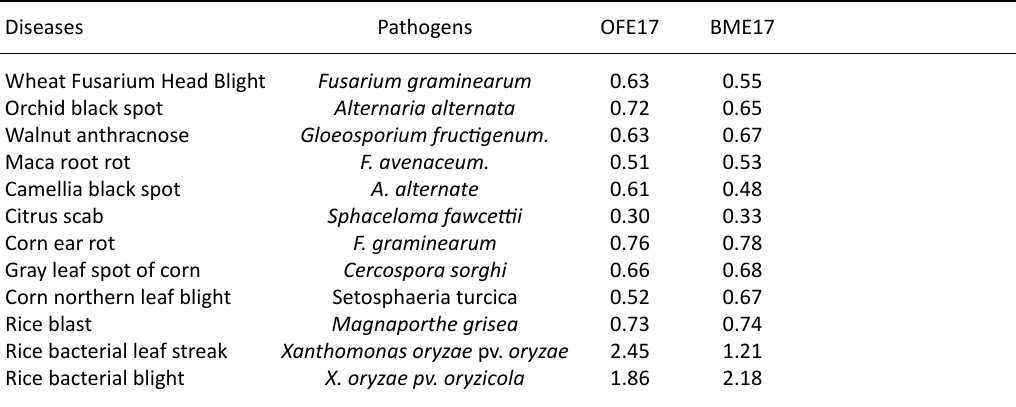
table 1. Two endophytes against different plant pathogens on plates Diseases